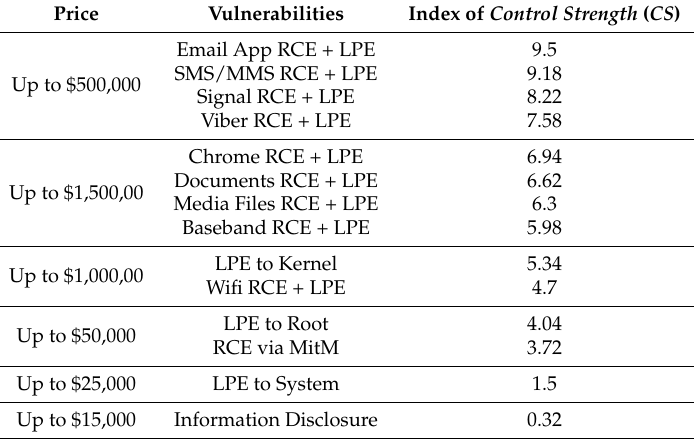
Table 4. During Zerodium’s vulnerabilities trade, this study generated price index based on